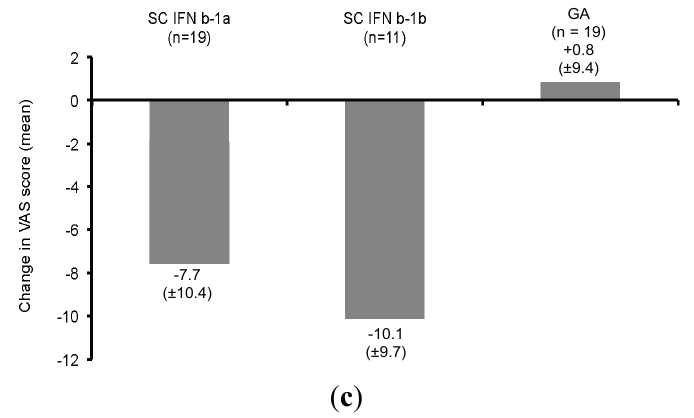
Figure 3. Mean difference (±SD) of the magnitude of injection fatigue ( a ), injection-related reactions ( b ) and flu-like symptoms ( c ) between current IM IFNb-1a and previous MS treatments at six months as rated by patients on a Visual Analog Scale (VAS) (1 = none to 25 = very intense, negative values indicate improvement).